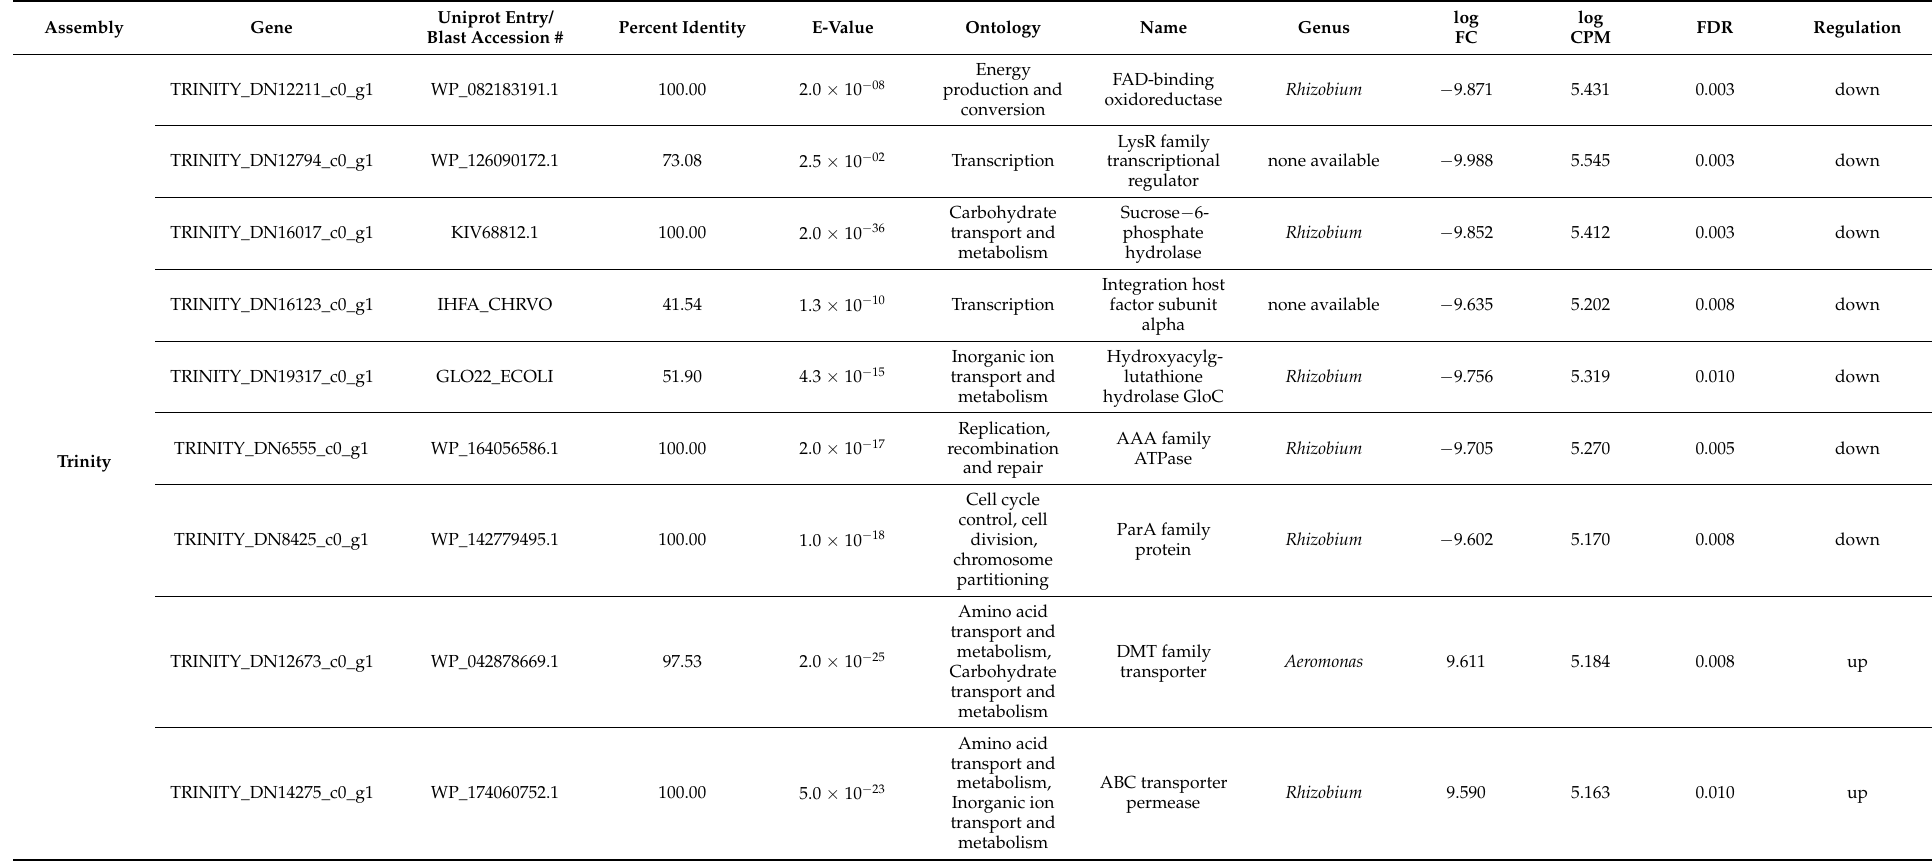
Table 1. Overview of the significantly differentially expressed genes. Shown here are the log fold changes (logFC), log counts per million (logCPM) and the p -value after the false discovery rate (FDR) correction, as calculated by edgeR for the pairwise comparison between cotton and polyester. If available, the SwissProt entry or BLAST accession number (March, 2021), as well as the organism determined by means of BLAST against the nucleotide database (May, 2021), are shown, as well as the determined up- or down-regulation of the respective gene for the cotton samples in comparison to the polyester samples. The functional orthologous groups were obtained using the EggNOG database [68]. If a protein has multiple domains, more than one functional orthologous groups is